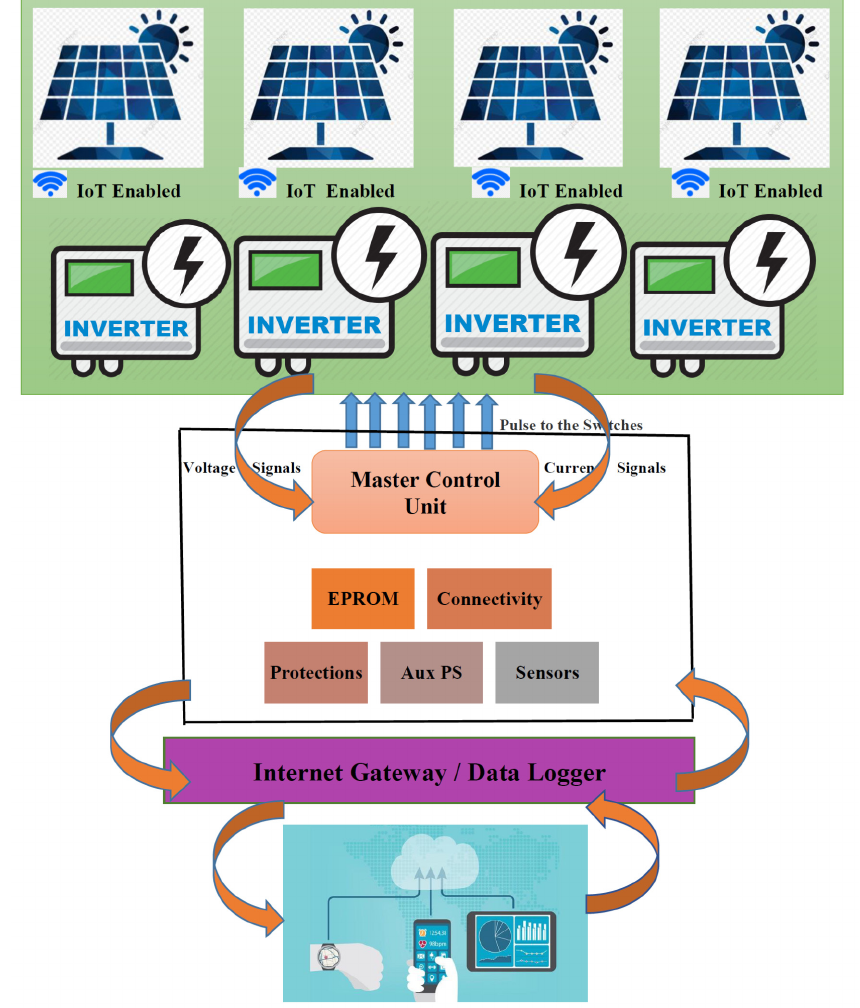
Figure 39. Smart PV system with inverter.